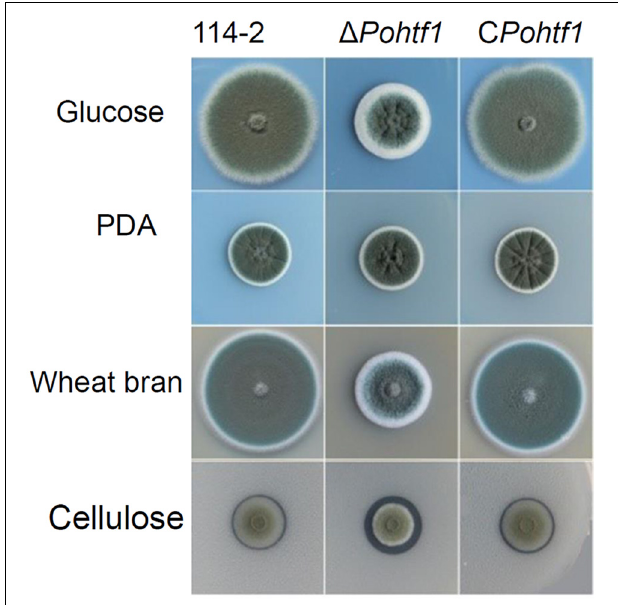
FIGURE 4 | Colony phenotypes of strains P. oxalicum 114-2, (cid:49) Pohtf1 and C Pohtf1 . Phenotype analysis was performed on Vogel’s medium plates containing 2% glucose or 1% cellulose, PDA plates and 10% wheat bran medium plates. The plates were incubated for 3 days at 30 ◦ C.